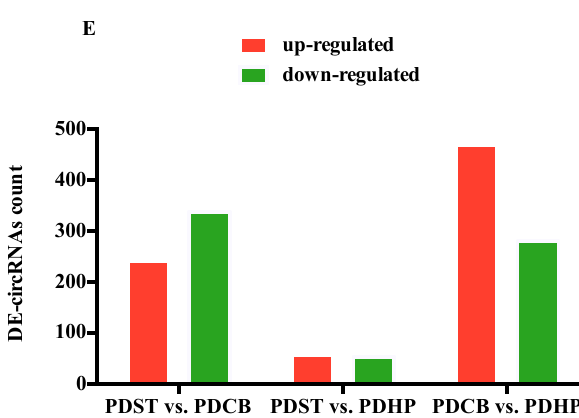
Figure 3. Di ff erentially expressed circRNAs of PDST vs. PDCB, PDST vs. PDHP, and PDCB vs. PDHP groups. ( A ) The heat map of the DE-circRNAs for the comparison of PDST and PDCB. ( B ) The heat map of the d DE-circRNAs for the comparison of PDST and PDHP. ( C ) The heat map of the DE-circRNAs for the comparison of PDCB and PDHP. ( D ) Overlap of significant DE-circRNAs in PDST vs. PDCB, PDST vs. PDHP, and PDCB vs. PDHP groups. All values represent the number of DE-circRNAs. ( E ) DE-circRNAs analysis of PDST vs. PDCB, PDST vs. PDHP, and PDCB vs. PDHP groups.